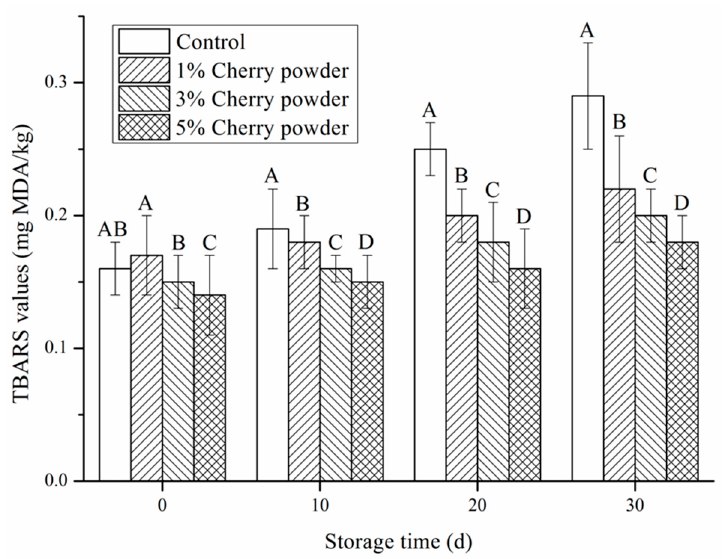
Figure 3. Effects of cherry powder addition on TBARS values of Jiangsu-type sausage during storage. Note: Different letters (A, B, C, D) indicate a significant difference ( p < 0.05).